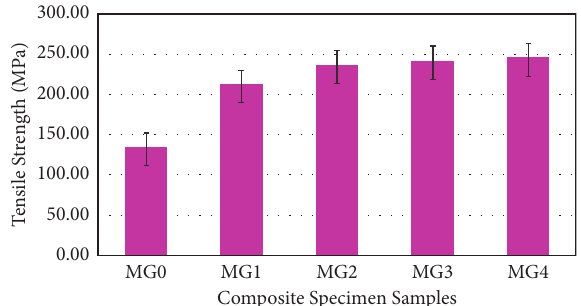
Figure 4: Tensile strength variation of composite specimens.